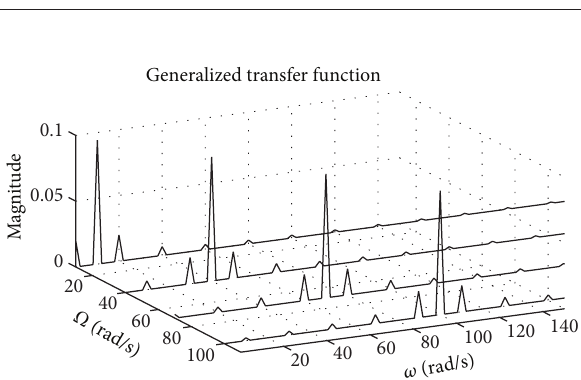
Figure 8: Bifrequency generalized admittance 𝐻 (𝜔,Ω) associated with the example circuit of Figure